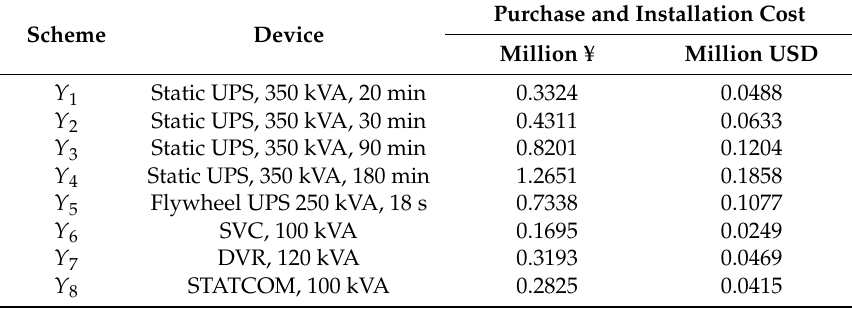
Table 2. Premium power investment schemes set provided by the new electric retail company (NERC).